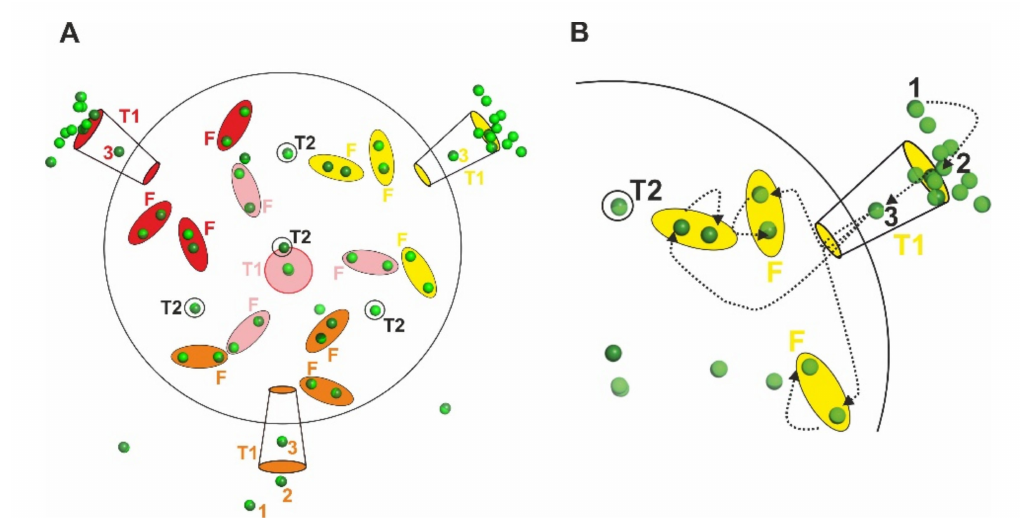
Figure 5. ( A ) Schematic representation of Yb 3+ ions localized at T1 pores, T2 pores and FOCs in Dps Yb 30 (dark green spheres) and Dps Yb 120 (light green spheres). A big black circle indicates the outline of the Dps protein. Each cylinder-shaped and encircled color group (red, pink, yellow and orange) shows one set of one T1 pore (written as T1) and three FOC sites (written as F). There are four T1 pores per Dps protein. The number of Yb 3+ ions shown here (dark green for Dps Yb 30 and light green for Dps Yb 120) show a difference on four of the T1 pores in this schematic. Two of four T1 pores are partially closed by interactions with neighboring Dps proteins in the crystallographic sphere, which restricts Yb 3+ ion access toward the T1 pores in pink and orange colors. There is one Yb 3+ on each T2 pore as shown by four black circles (written as T2) in the Dps protein. ( B ) One T1 pore spreads Yb 3+ ions over three FOC sites. Dotted arrows indicate ideal ways to transport Yb 3+ ions from T1 to the